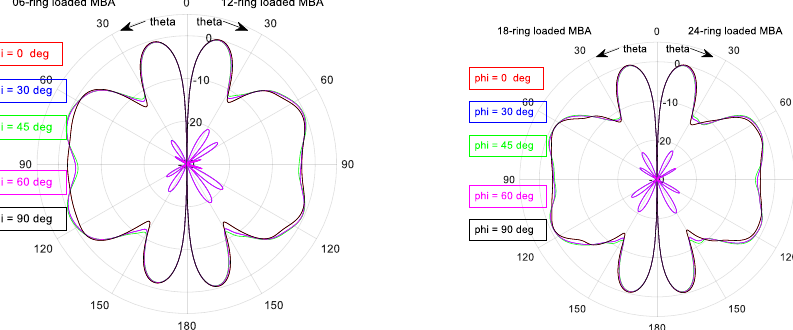
Figure A3. 2D patterns at 10 GHz of 6-, 12-, 18- and 24-ring-loaded MBA in different cutting planes.